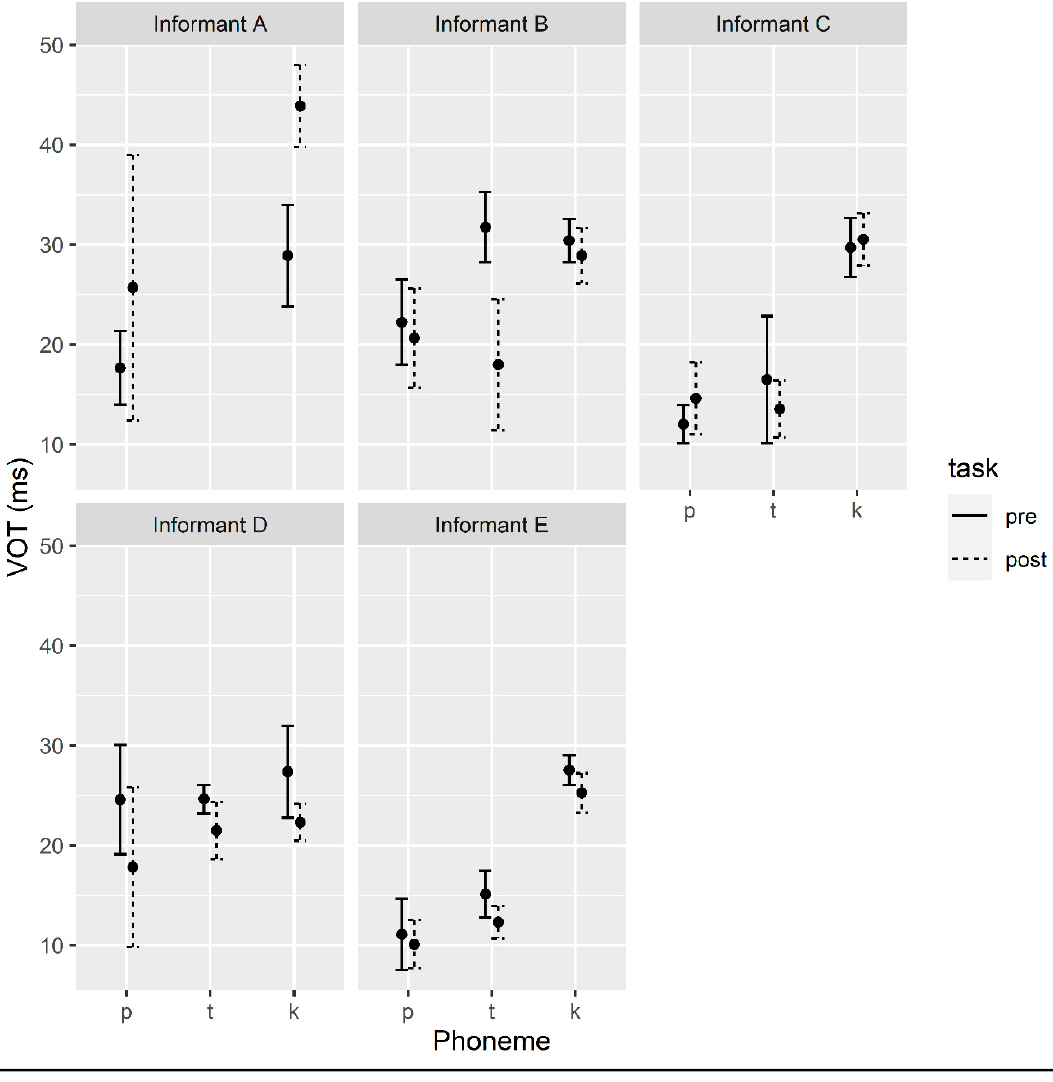
Figure 5. Voice onset time (VOT) values for pre-semester and post-semester measurements of voiceless consonants for each informant.